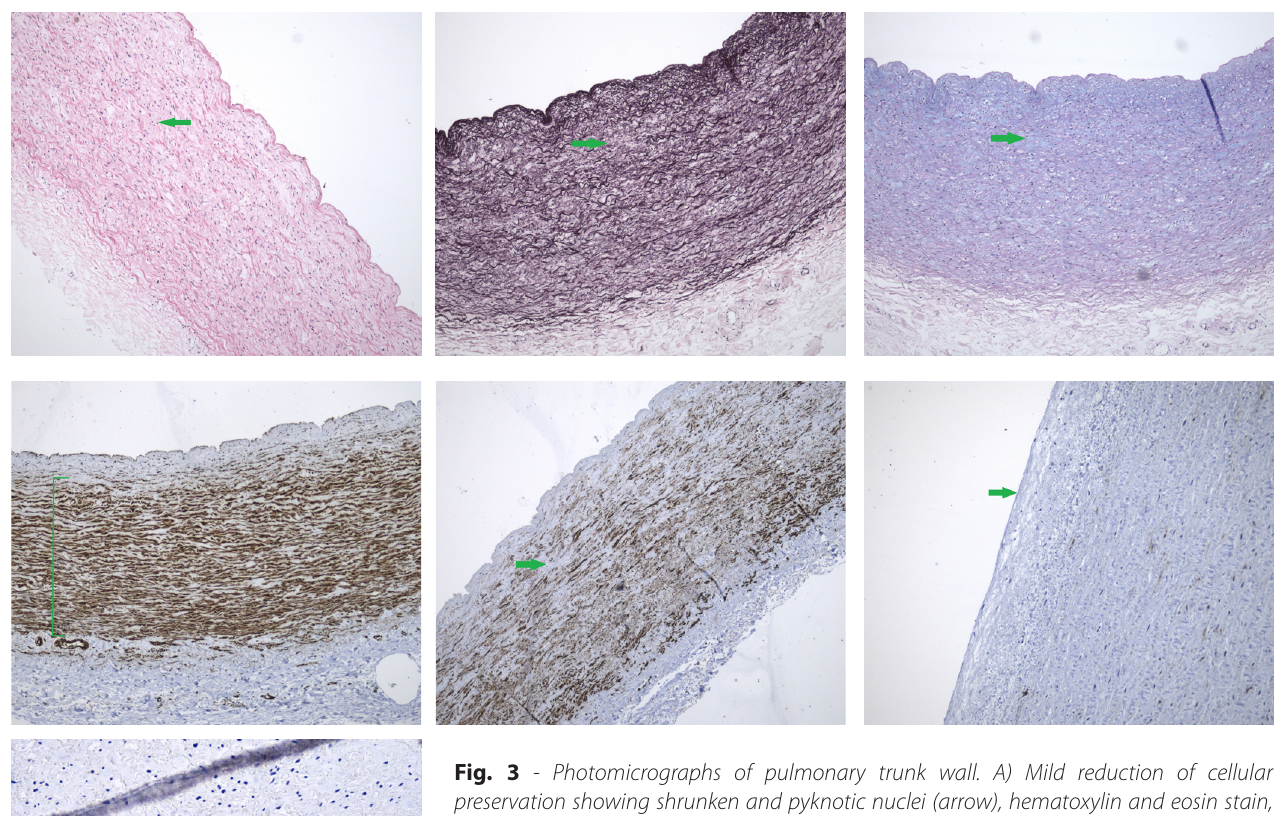
Fig. 3 - Photomicrographs of pulmonary trunk wall. A) Mild reduction of cellular preservation showing shrunken and pyknotic nuclei (arrow), hematoxylin and eosin stain, magnification 100×; B) mild fragmentation and loss of elastic fibers (arrow), Weigert’s resorcin fuchsin stain, magnification 100×; C) mild focal intralamellar mucoid extracellular matrix accumulations (arrow), Alcian blue/periodic acid-Schiff stain, magnification 100×; D) anti-vimentin immunohistochemical stain demonstrating well preserved mesenchymal cells (bar), magnification 100×; E) anti-h-caldesmon immunohistochemical stain demonstrating mild focal loss of smooth muscle cells (arrow), magnification 100×; F) anti- CD34 immunohistochemical stain demonstrating complete loss of endothelial cells (arrow), magnification 200×; G) anti-S100β immunohistochemical stain demonstrating a few positive antigen-presenting dendritic cells (circle), magnification